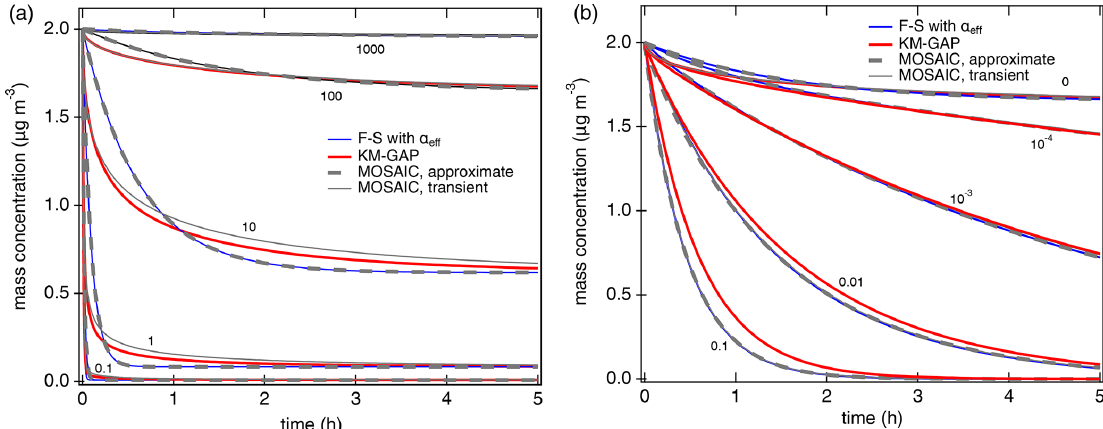
Figure 2. Temporal evolution of the gas-phase concentration of organic compounds interacting with semi-solid seed aerosol particles ( α s = 1, ω = 2 × 10 4 cms − 1 , D b = 10 − 15 cm 2 s − 1 , ρ p = 1gcm − 3 ). (a) Non-reactive partitioning of compounds with different volatilities ( C 0 = 0.1, 1, 10, 100, 1000µgm − 3 ). (b) Reactive uptake of semi-volatile compounds ( C 0 = 100µgm − 3 ) with different first-order bulk reaction rate coefficients ( k b = 0, 10 − 4 , 10 − 3 , 0.01, 0.1s − 1 ). The red lines are simulation results of KM-GAP, and the blue lines are the results